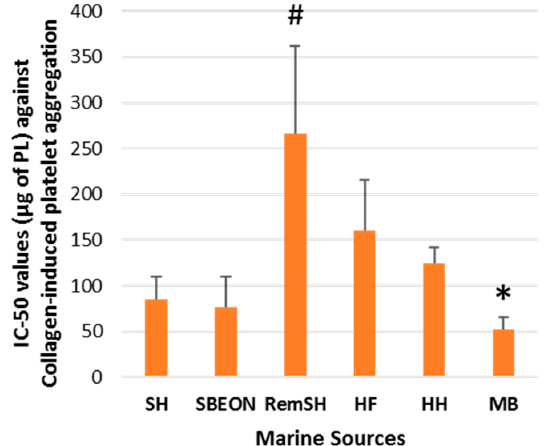
Figure 4. Antithrombotic activities of PL extracts from salmon, herring, and boarfish by-products against collagen-induced aggregation of human platelets. Results are expressed as IC 50 (half-maximal inhibitory concentration) values that reflect the inhibitory strength of each PL extract against collagen-induced platelet aggregation and is expressed as mean values of µ g of PL in the aggregometer cuvette that causes 50% of inhibition of collagen-induced aggregation of platelets in hPRP ± SD. It should be noted that the lower the IC 50 value, the stronger the inhibition against the platelet agonist tested. * and # indicate statistically significant di ff erences ( p < 0.05) for the most and least bioactive extracts, respectively. PL: polar lipid; SH: salmon head, SBEON: salmon brain, eyes and main optic nerve; RemSH: the remnants of SH after the removal of SBEON; HF: herring fillet; HH: herring head; MB: minced boarfish; hPRP: human platelet-rich plasma; SD: standard